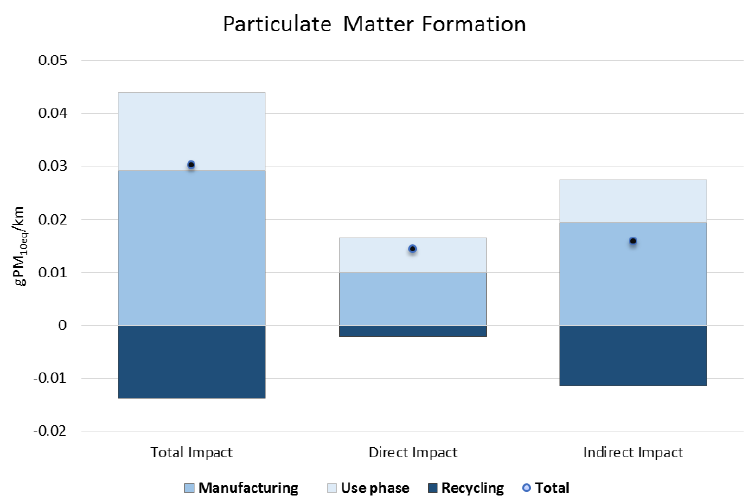
Figure 5. Photochemical Oxidation Formation impact per km.